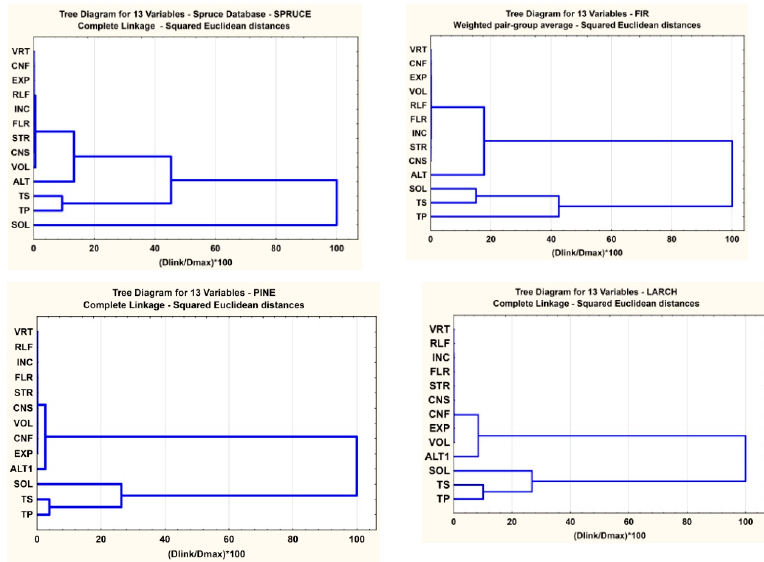
Figure 12. Cluster diagram: complete linkage squared Euclidean distances.